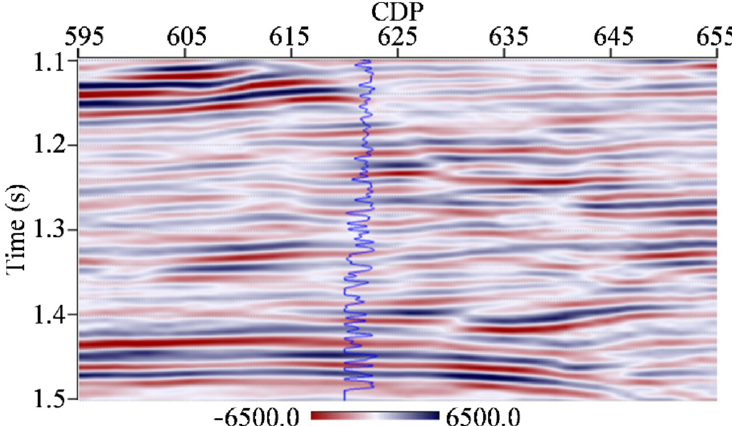
Figure 8. The original seismic data profile.